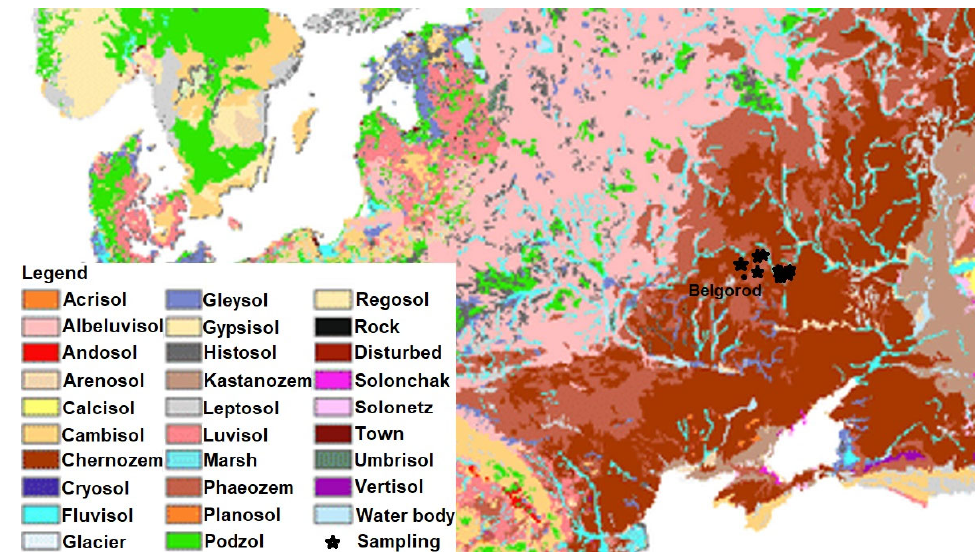
Figure 1. Sampling area on the soil map of eastern Europe.